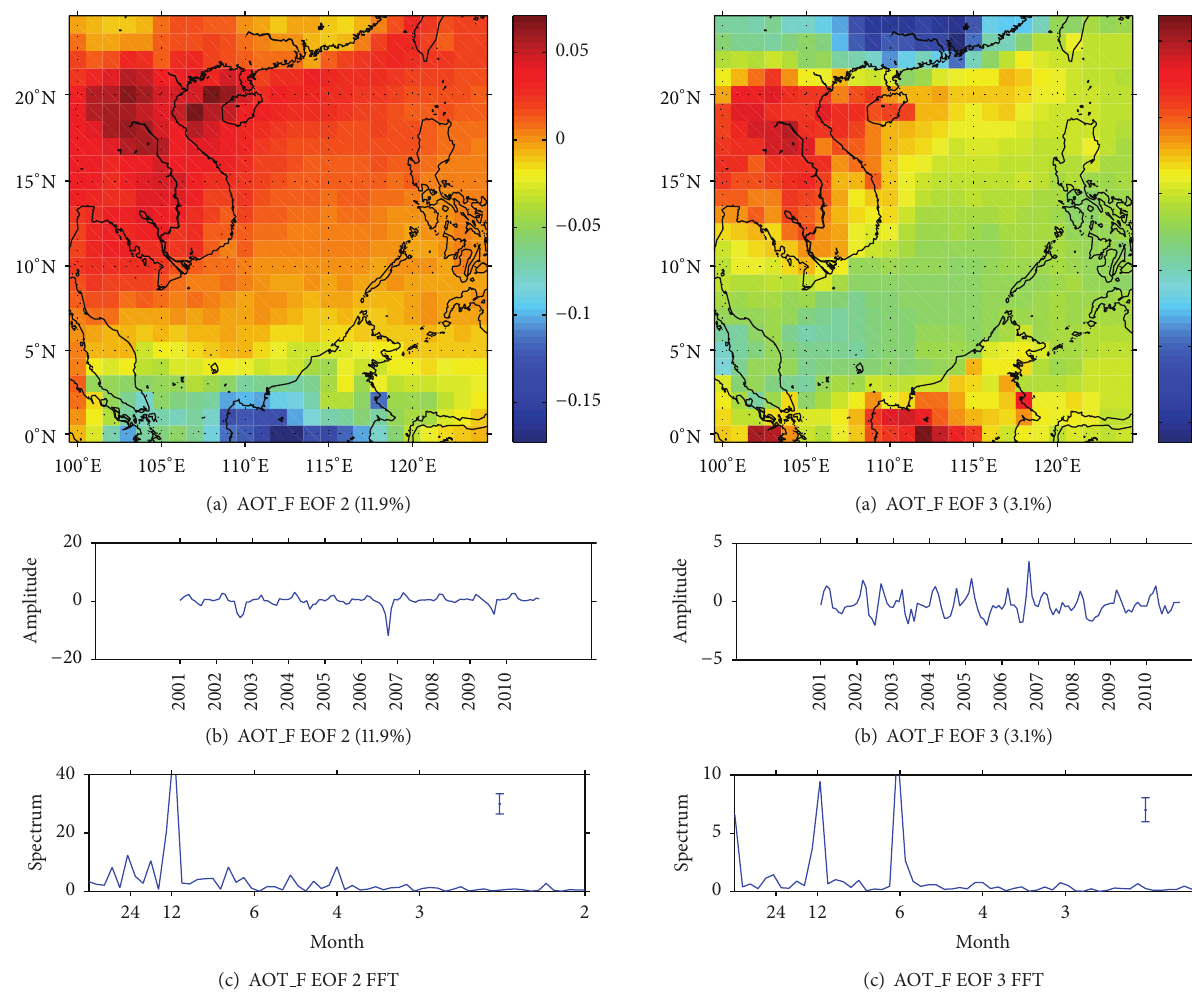
Figure 6: The same as Figure 5 but EOF mode 2 of AOT F. Figure 7: The same as Figure 5 but EOF mode 3 of AOT